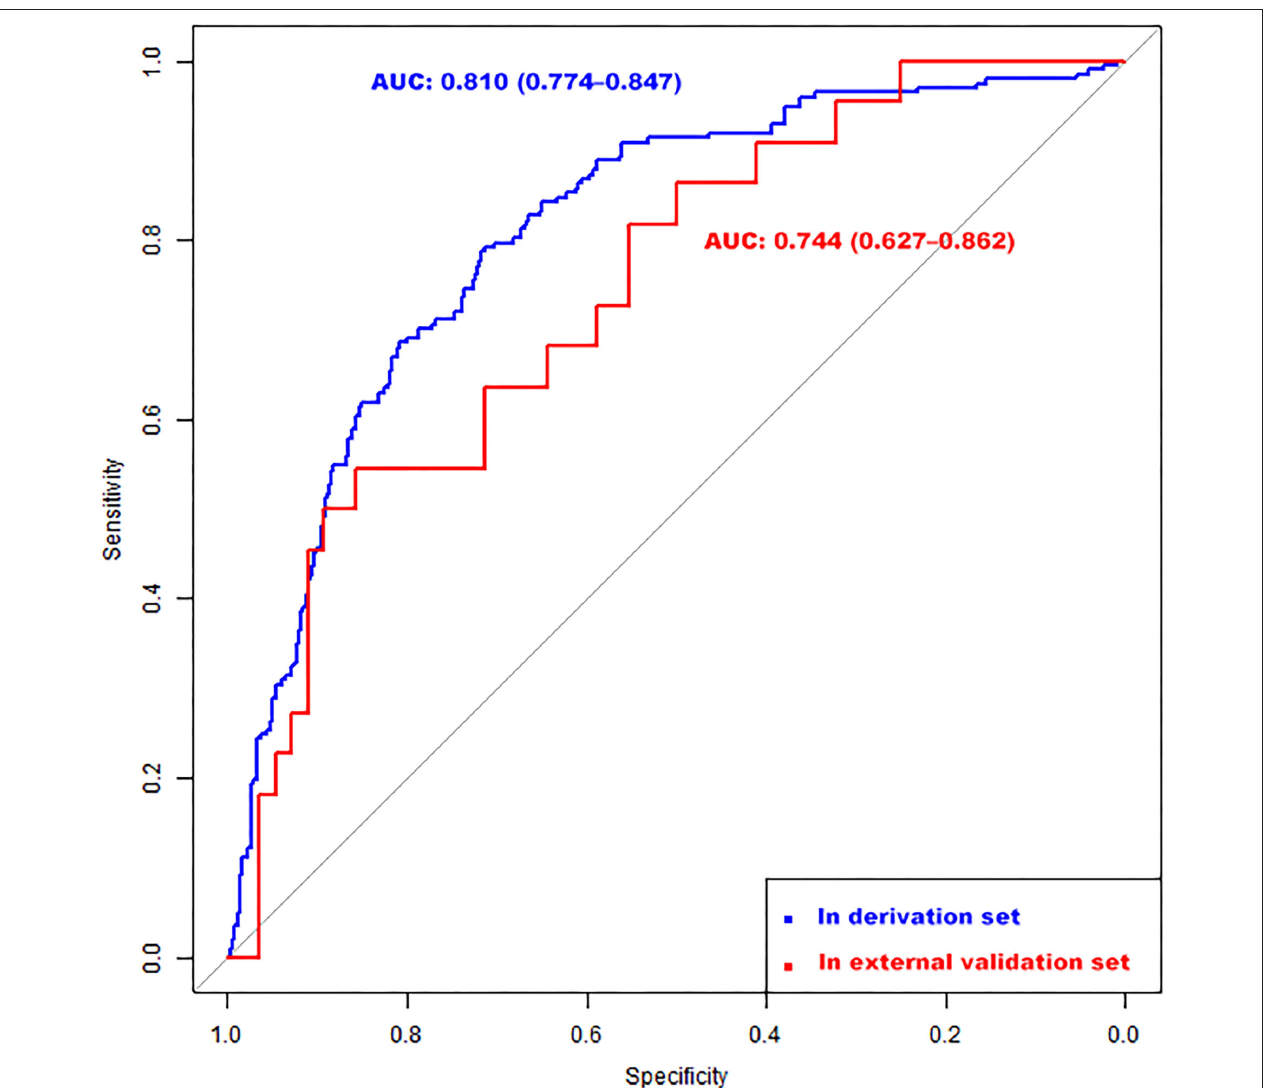
FIGURE 2 | Receiver operating characteristic (ROC) curves of the nomogram for identifying high-risk IA among multiple aneurysms in the derivation (AUC = 0.81; 95% CI, 0.774–0.847) and external validation (AUC = 0.744; 95% CI, 0.627–0.862) set. CI, confidence